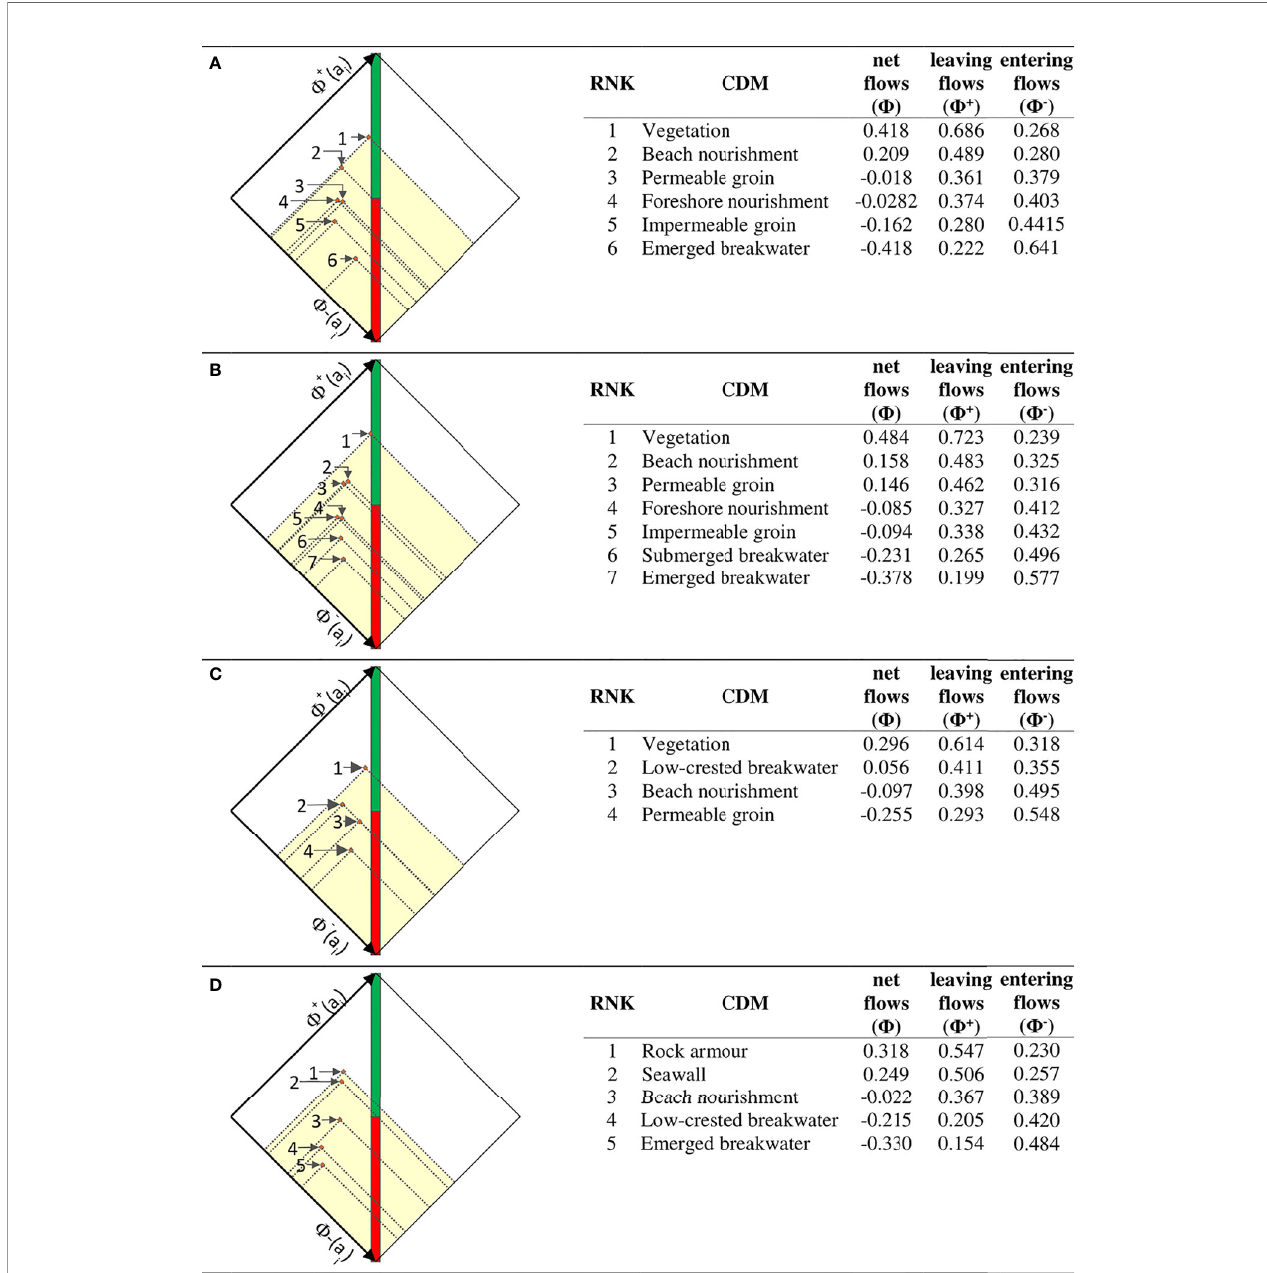
FIGURE 7 | CDMs hierarchization presented in a diamond fi gure with the net, leaving and entering fl ows for each study site; (A) Pessamit; (B) Gallix; (C) Baie-des- Capucins; (D)